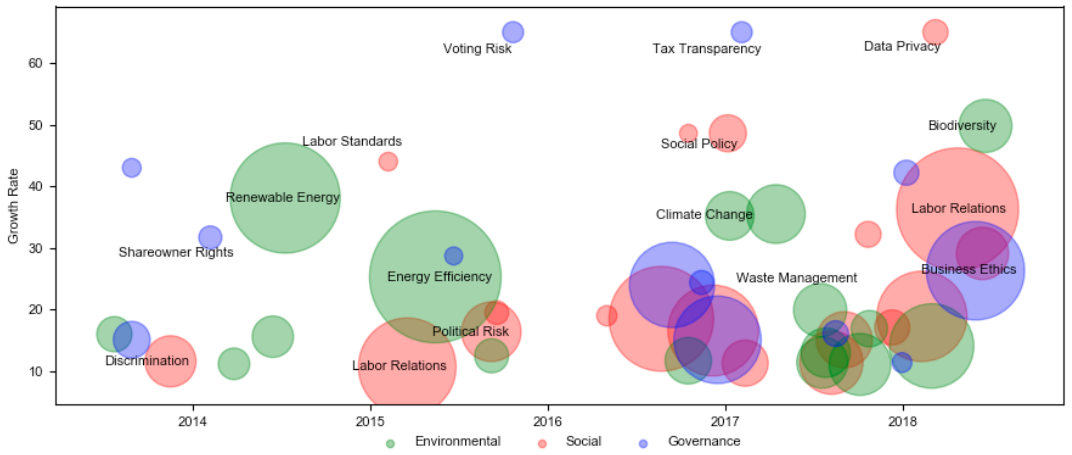
Figure 6. Thematic trend analysis of growth in ESG popularity during earnings calls over the past 5 years. Each bubble correspond to an ESG factor and the size reflects the number of ESG relevant mentions in the